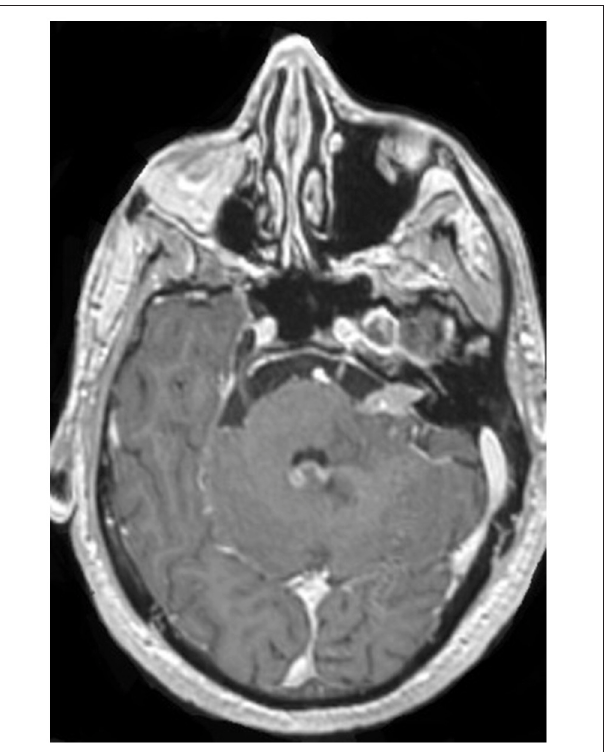
FIGURE 1 | Axial MRI with nodular contrast enhancement in VII cranial nerve and enhancement in fourth ventricle, patient with diagnosis of lung cancer.